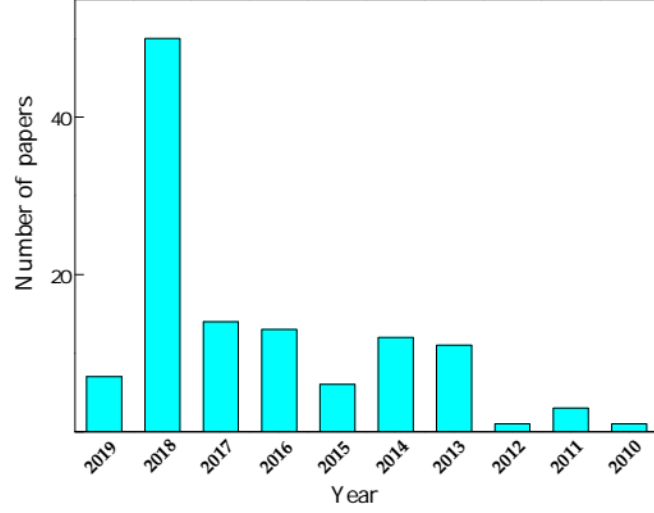
Figure 3. Literature bibliography included in this review.